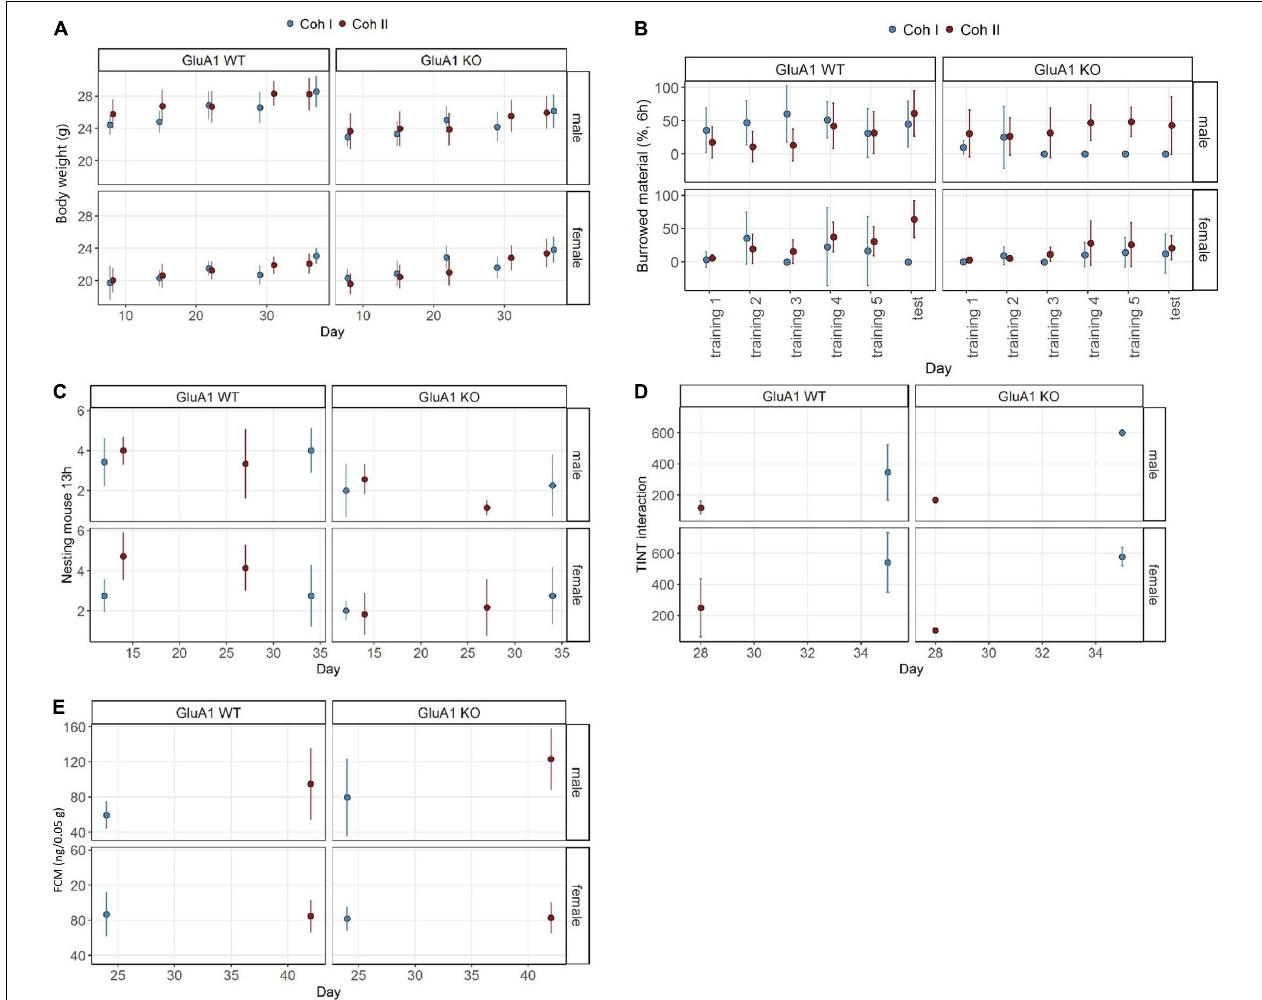
FIGURE 2 | Well-being-associated parameters in GluA1 KO and WT. Several cohort and sex-specific differences became evident. (A) GluA1 KO males show reduced body weight. (B) GluA1 KO males burrow less than WT, but not consistent over both cohorts, while the females rarely perform at all. (C) Nest complexity is lower in GluA1 KO. (D) The cohort largely affects the time to integrate into nest test (TINT). (E) GluA1 KO males have higher baseline concentrations of fecal corticosterone metabolites (FCMs) in only one cohort. The concentration in females was comparable between cohorts and genotypes. Data was analyzed using linear models (lm) in R, GluA1 KO n = 11, n = 14, controls = 14, = 11, error bars are mean ± 95% ♂ ♀ ♂ ♀